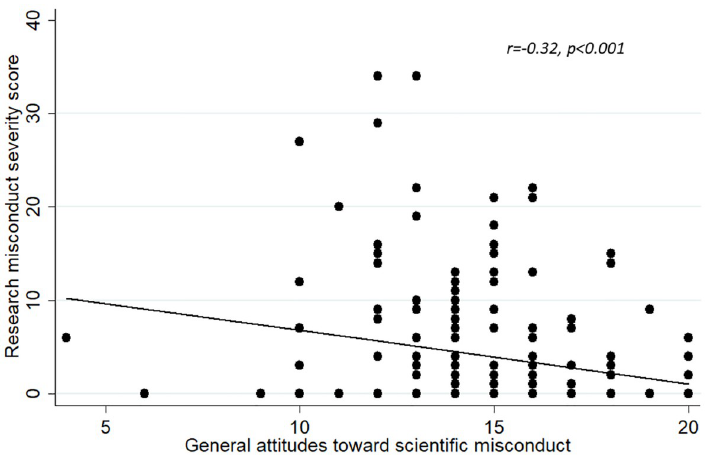
Fig 3. Correlation between the scores of the “general attitudes toward scientific misconduct” and the Research Misconduct Severity